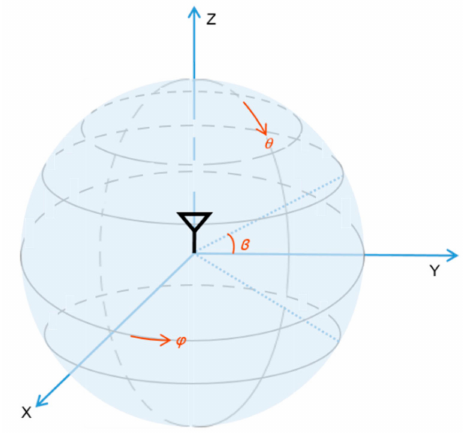
Figure 7. The test schematic of total radiated power ( TRP